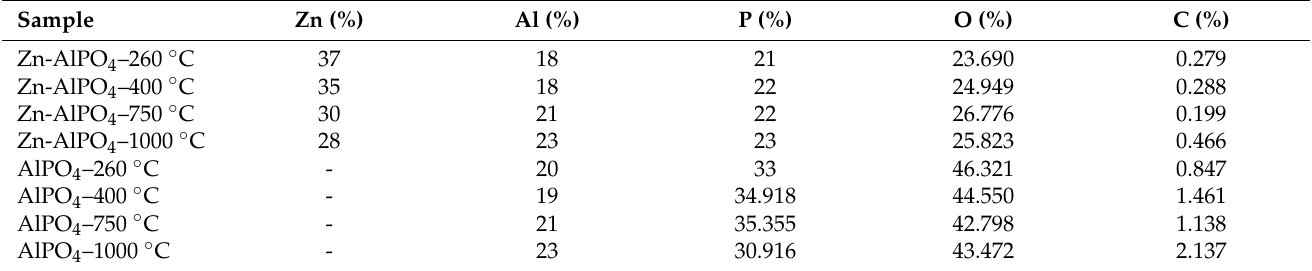
Table 2. Approximate percentages of the constituting elements in the Zn-AlPO 4 and AlPO 4 samples.